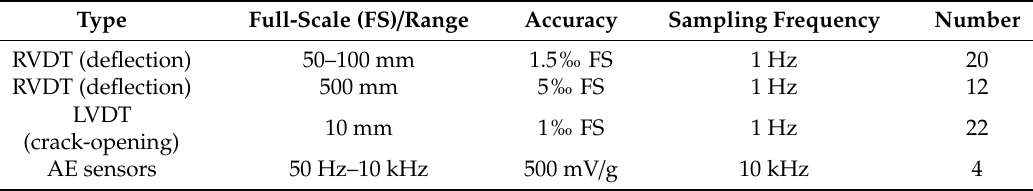
Table 2. Technical features of sensors installed on the viaduct (only sensors relevant in our analysis).